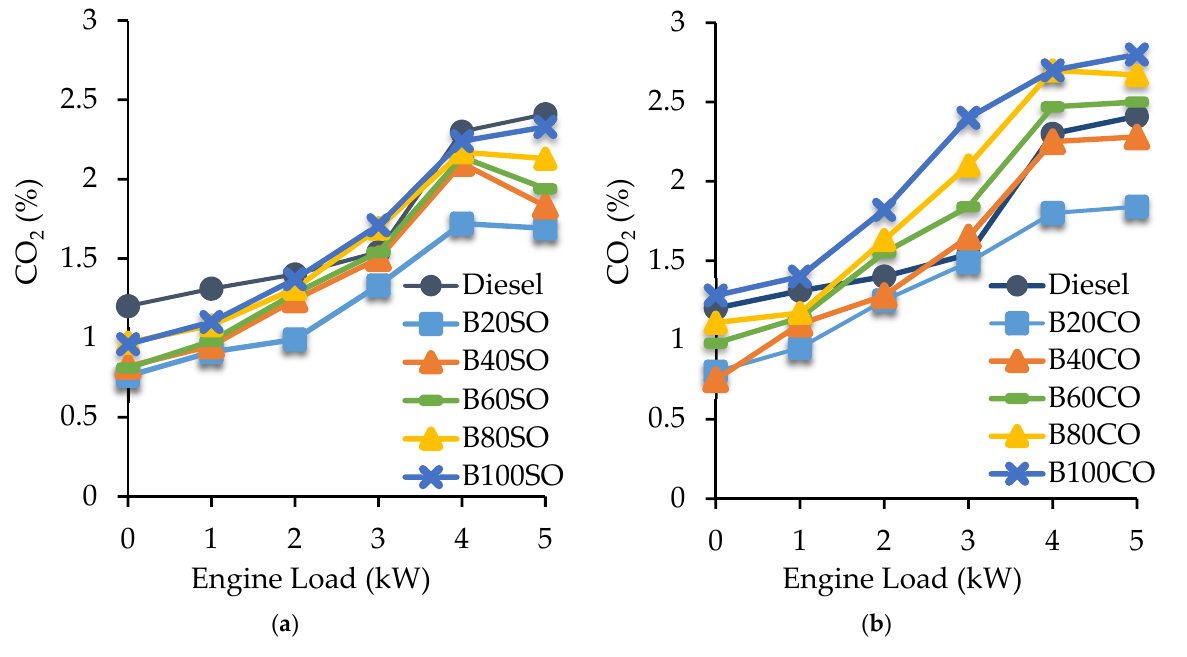
Figure 7. Carbon dioxide (CO 2 ) emissions (%) generated under different engine operating powers (from 0 to 5 kW) using the triple blends: diesel/ABE/sunflower oil ( a ) and diesel/ABE/castor oil ( b ).